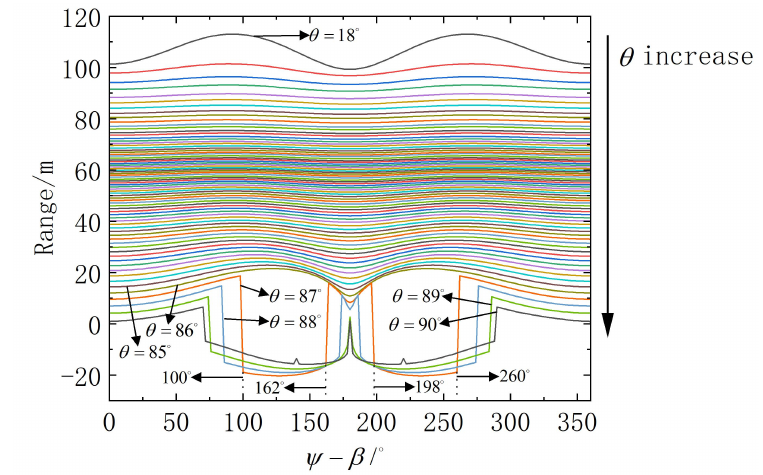
Figure 6. Simulation results of the range of a water cannon under constant horizontal wind distur- bances.